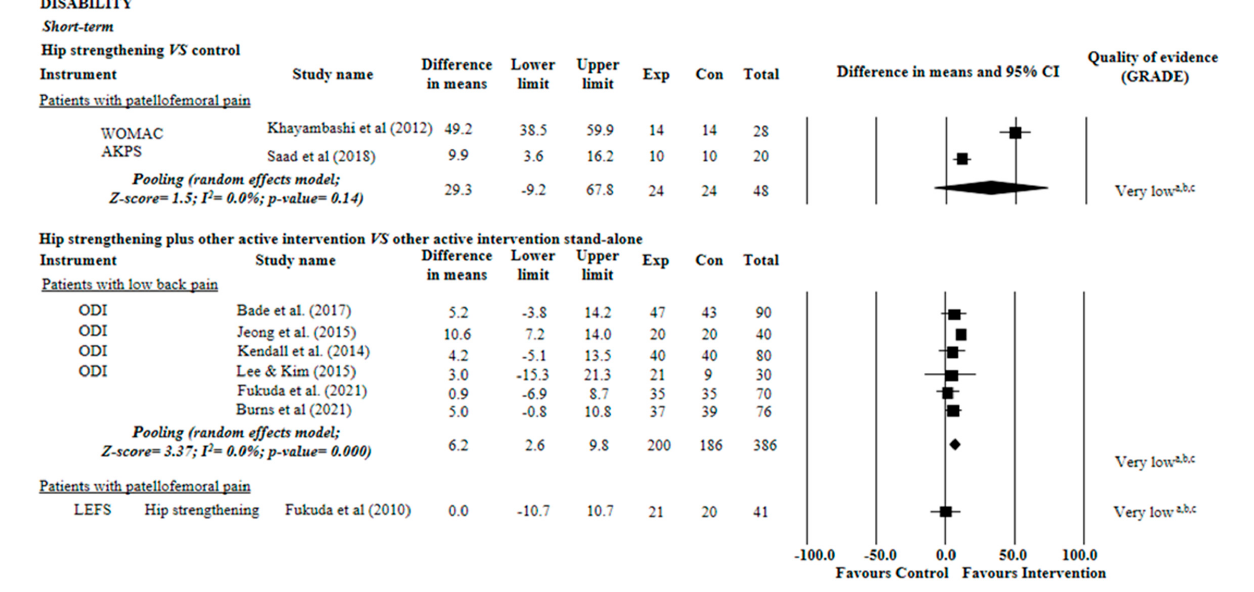
Figure 3. Summary of evidence of the effect of hip strengthening on disability. Control: sham, placebo, no intervention, or waiting list. (a) Downgraded owing to imprecision: less than 400 participants included in the meta-analysis (sample of less than 200 was considered serious imprecision, and the evidence was down- graded by two levels); (b) Downgraded owing to inconsistency: I 2 statistic was higher than 50% or pooling was not possible (poor overlap between the confidence intervals of the effects of the studies included in the meta-analysis was considered serious inconsistency, and the evidence was downgraded by two levels); (c) Downgraded owing to risk of bias: more than 25% of the participants in the meta-analysis were from trials with a high risk of bias (i.e., PEDro score < 6 of 10) [30– 38].